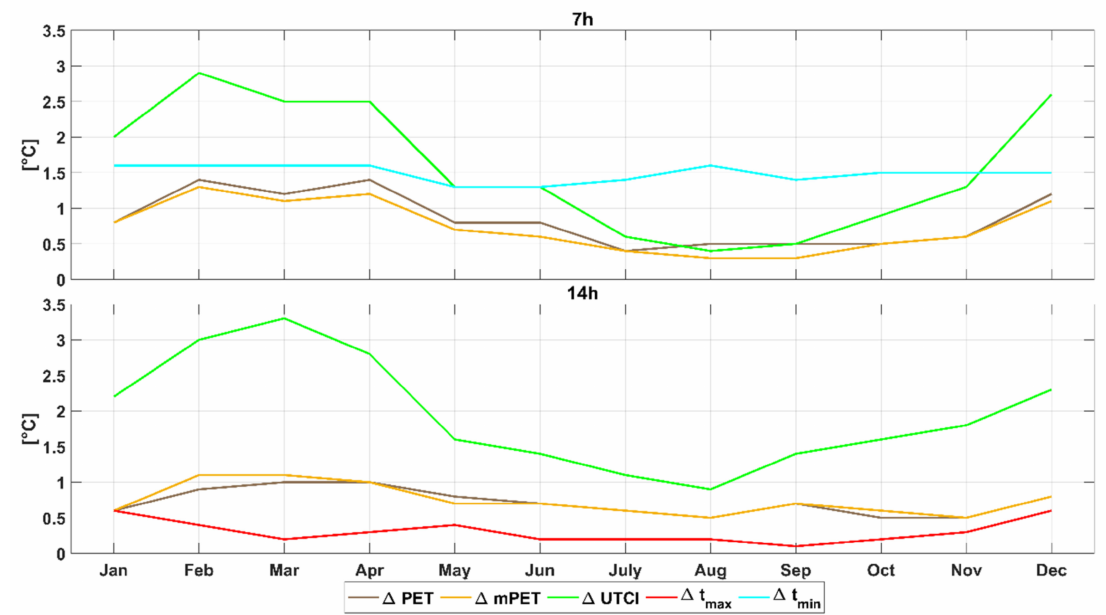
Figure 5. Average monthly and annual differences of PET, mPET, UTCI, tmax and tmin at 7 h and 14 h between Belgrade BG (urban) and Surcin SU (suburban) for the period